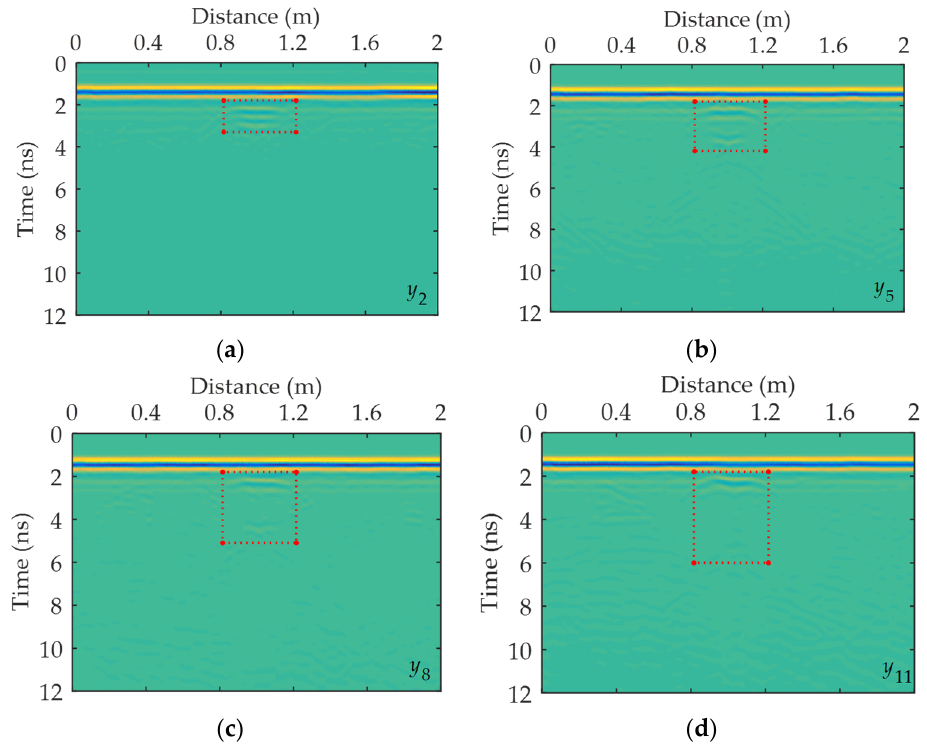
Figure 5. GPR profiles of three longitudinal survey lines: ( a ) survey line x 1 ; ( b ) survey line x 2 ; ( c ) survey line x 3 .